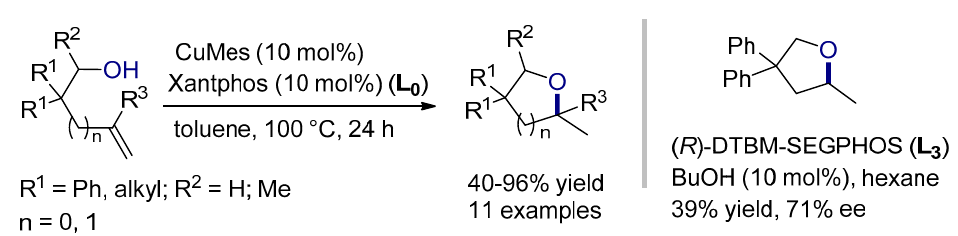
Figure 20. Cu(I)-Xantphos-catalyzed cyclohydroalkoxylation of